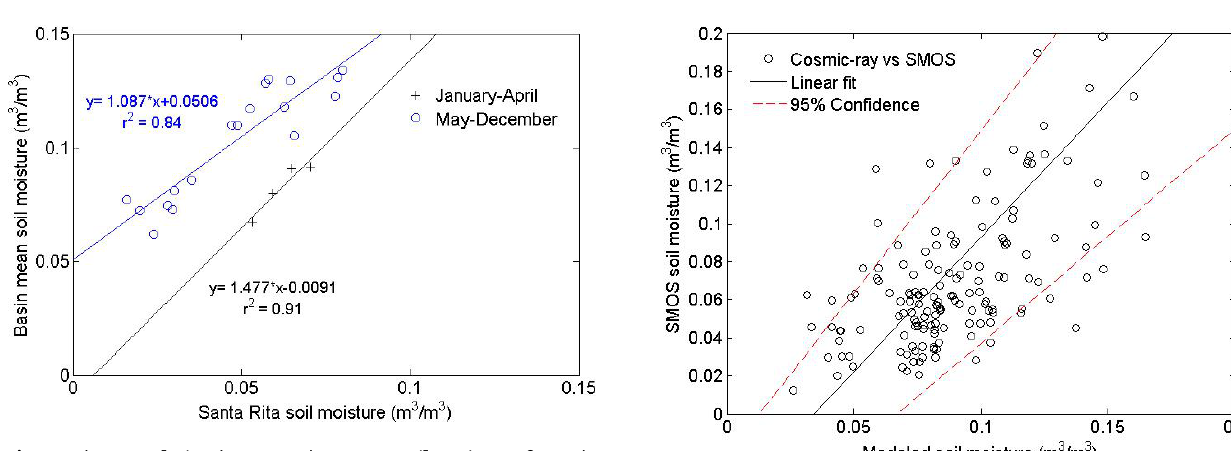
Fig. 7. The correlation between the mean soil moisture from the 22 cosmic-ray rover surveys with the corresponding soil moisture from the Santa Rita COSMOS point measurement. The correlation changes with season and is approximated by separating the winter months (January–April) from the dry season and monsoon (May– December) surveys.